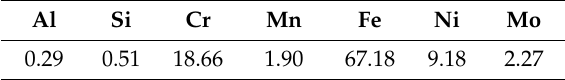
Table 4. Elemental composition of powder A measured by EDX. Values are expressed as counts-per- second / electronvolt (cps / eV).